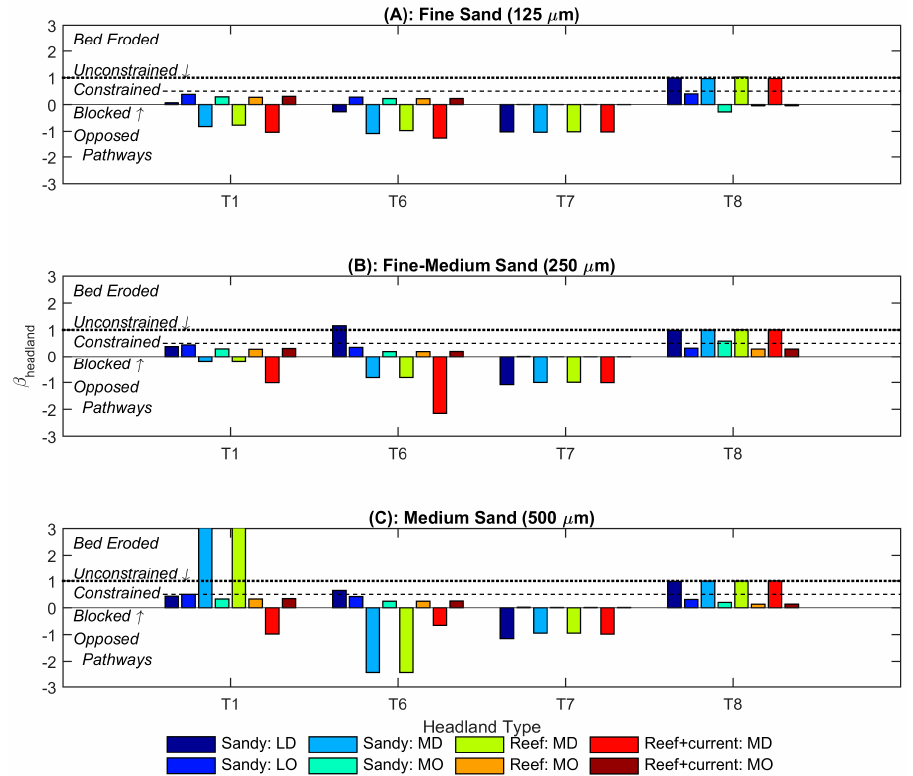
Figure 7. Sediment bypassing ratios between northern and southern shoulders for ( A ) fine (125 µ m), ( B ) fine–medium (250 µ m), and ( C ) medium (500 µ m) sand under variable forcing conditions and substrates (Table 2). Baseline calculations were excluded as sediment transport volumes were negligible. The dashed line indicates β headland = 0.5 as a division inside the “constrained” zone. See Equation (13) for definitions of β headland categories.